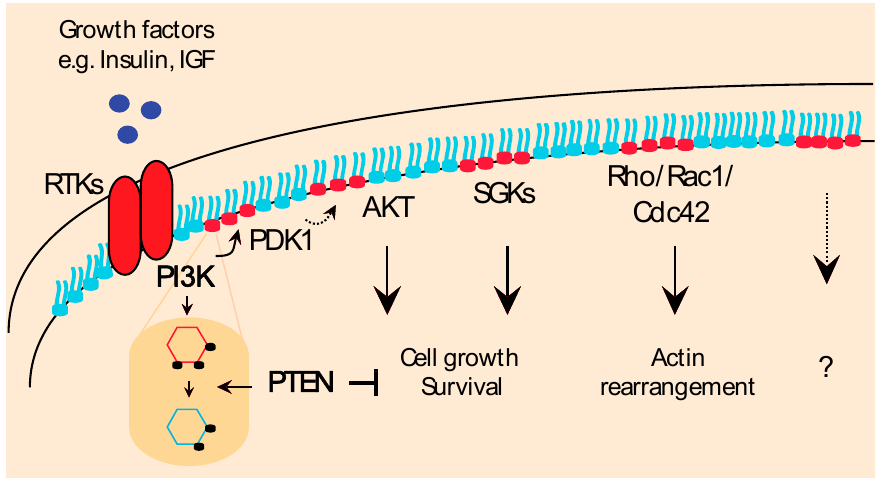
Figure 1. The phosphatase and tensin homolog deleted on Chromosome 10- phosphatidylinositol 3-kinase (PTEN–PI3K) axis modulates activation of multiple pro-survival signal transduction pathways. In physiological conditions, growth factors stimulate PI3K which once active phosphorylates the phospholipid substrate phosphatidylinositol (4,5)-bisphosphate (PIP2) to generate the second messenger phosphatidylinositol (3,4,5)-trisphosphate (PIP3). PIP3 recruits and activates a number of functional targets, such as phosphoinositide-dependent protein kinase-1 (PDK1), AKT isoforms, the serum and glucocorticoids-regulated kinases, (SGKs) signaling pathways and the Rho family of GTPases (Rho/Rac1/Cdc42), and promotes a plethora of biological effects to sustain cell growth, proliferation and cytoskeleton modification. The lipid phosphatase PTEN converts PIP3 to PIP2 and terminates propagation of the growth signal to maintain normal cellular and tissue homeostasis. RTK: Receptor Tyrosine Kinases; IGF: Insulin-like Growth Factors